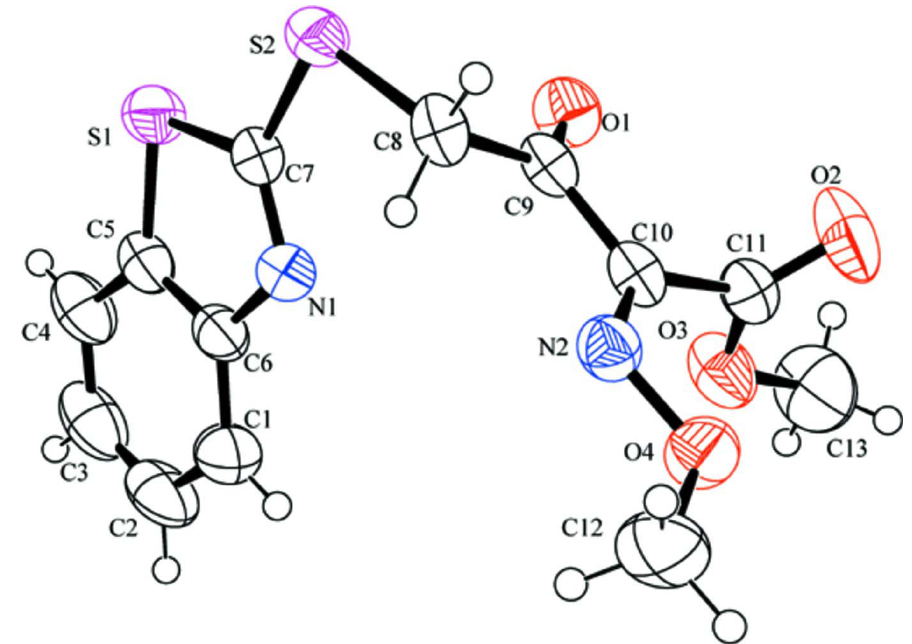
Figure 1 The molecular structure of (I) showing the atom-labelling scheme. Displacement ellipsoids are drawn at the 50% probability